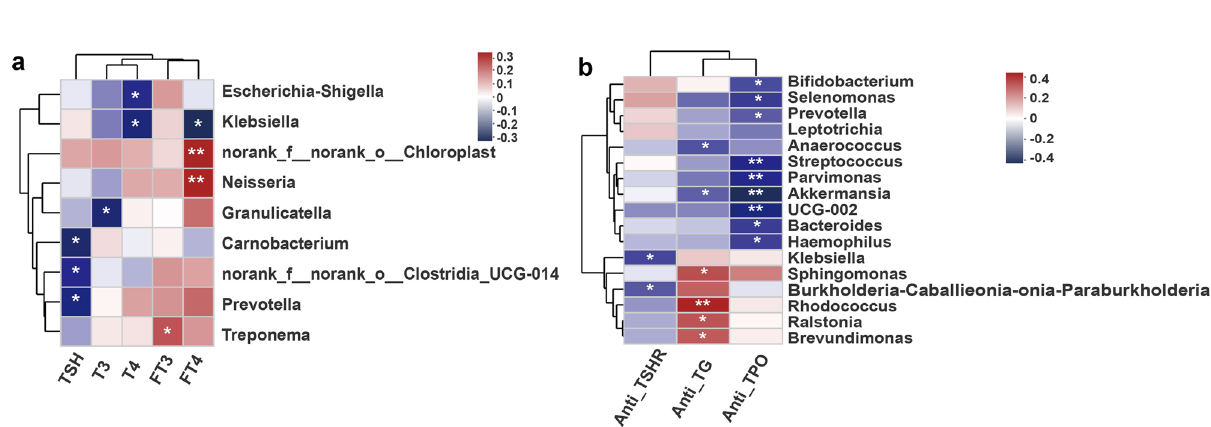
Fig. 3 Heatmap of Spearman ’ s correlation analysis between the speci fi c PTC intratumor microbiome and the clinical factors. a Heatmap of Spearman ’ s correlation analysis between the speci fi c bacterial and thyroid-related hormones. * p < 0.05 and ** p < 0.01. Heatmap color keys indicate Spearman correlation coef fi cient. b Heatmap of Spearman ’ s correlation analysis between the speci fi c bacterial and thyroid diseases (AITD)-related antibodies. * p < 0.05 and ** p < 0.01. Heatmap color keys indicate Spearman correlation coef fi